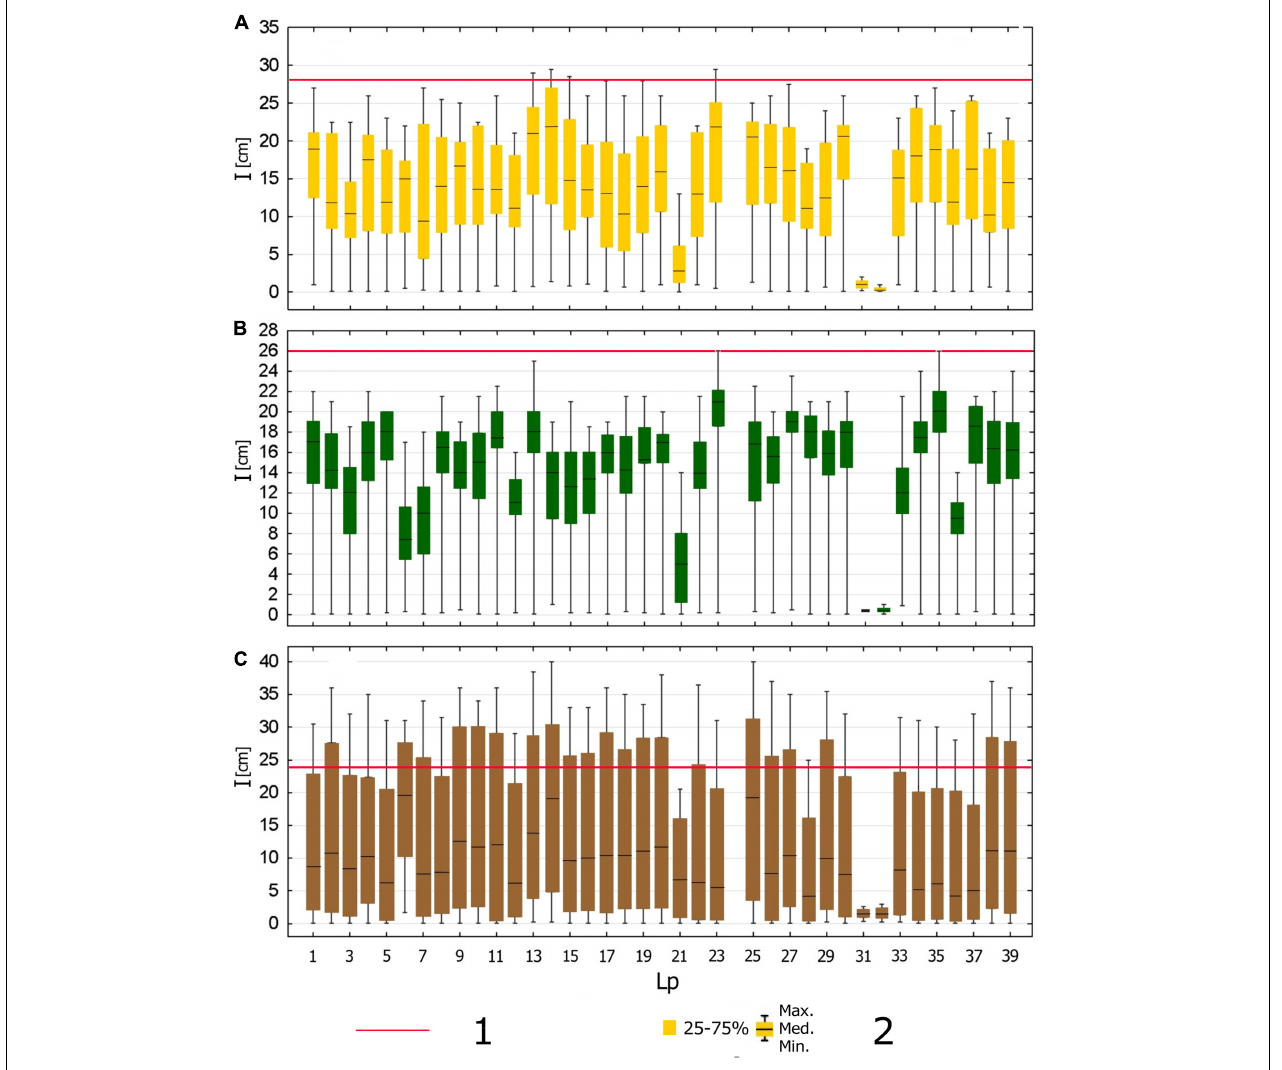
FIGURE 4 | Ice thickness on the water bodies of the Silesian Upland in the (A) first, (B) second, and (C) third winter season: I–ice thickness, Lp–ordinal number (numbering as in Table 1 ). 1 - the maximum ice thickness values obtained from modelling using the Stefan’s (1891) equation, 2 - statistical